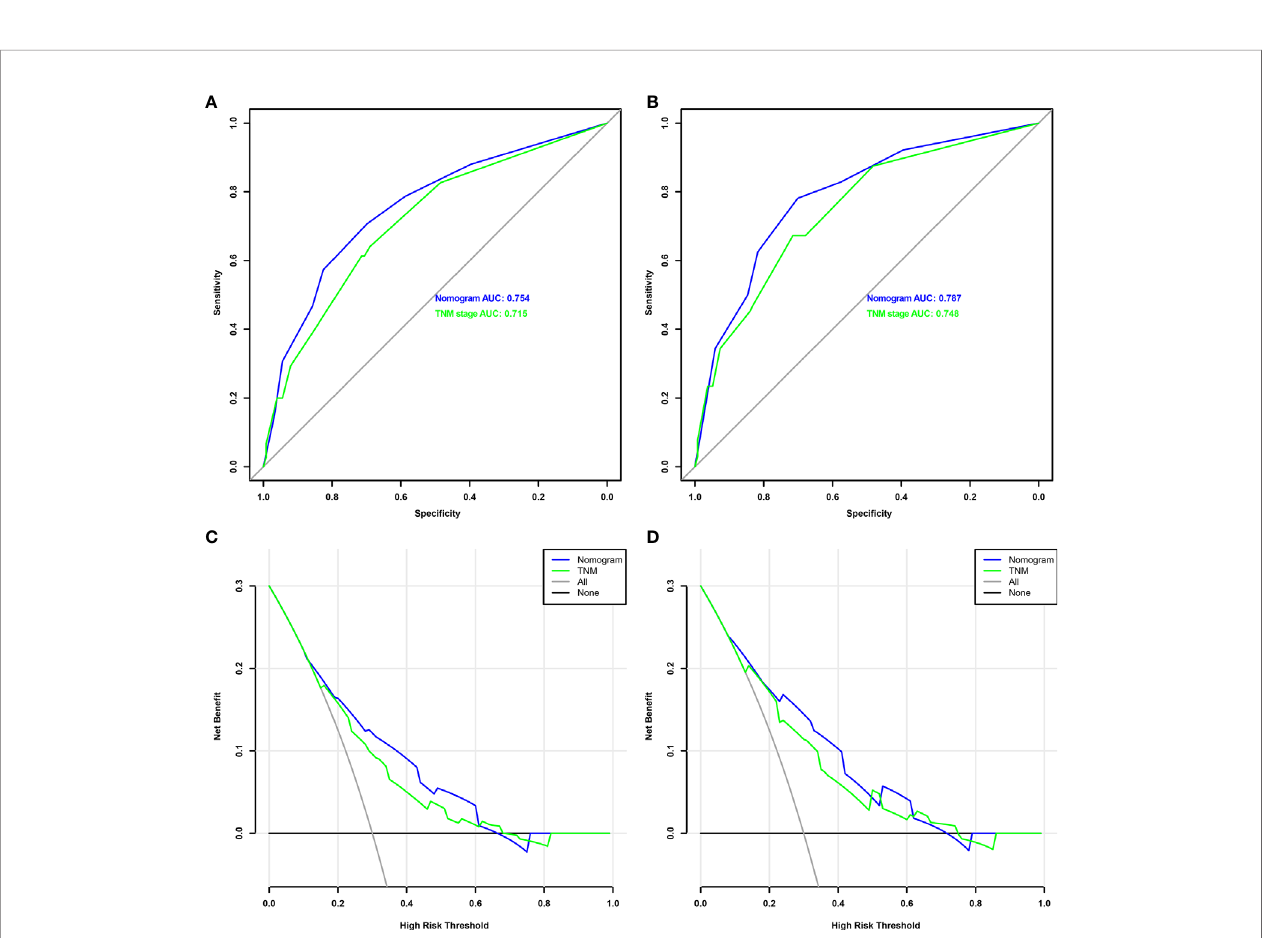
FIGURE 3 | ROC analysis of nomogram and TNM stage to predict the OS (A) and DFS (B) in patients who underwent radical cystectomy. The decision curve analysis of nomogram and TNM stage for survival bene fi t in OS (C) and DFS (D) . ROC, receiver operating characteristic; OS, overall survival; DFS, disease-free